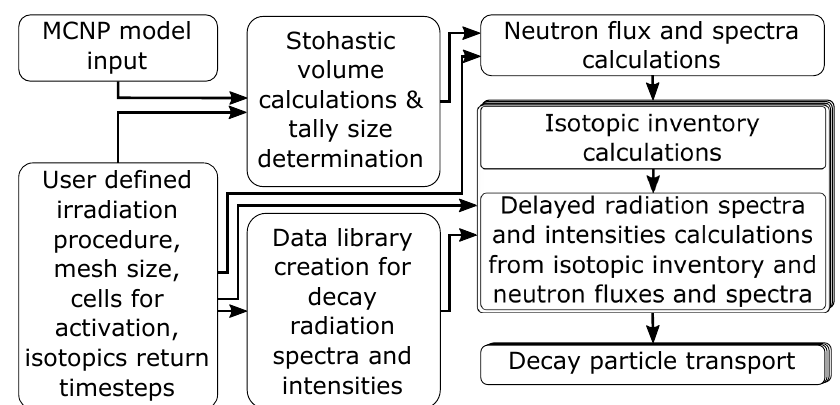
Figure 1: JSIR2S workflow schematic.